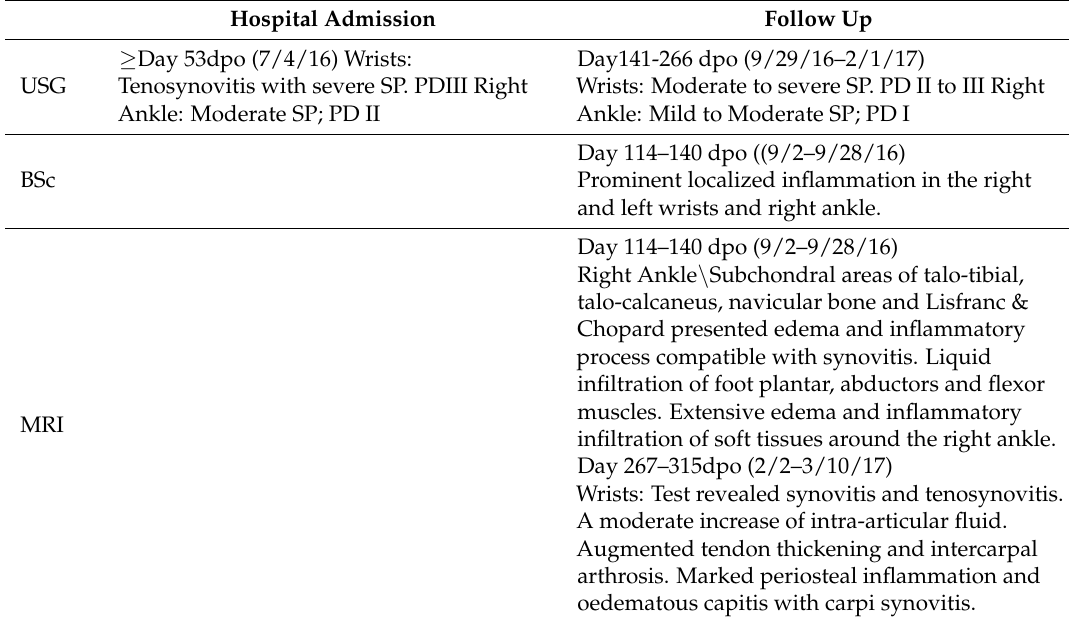
Table 2. Imaging studies of arboviral arthritis in SLE.